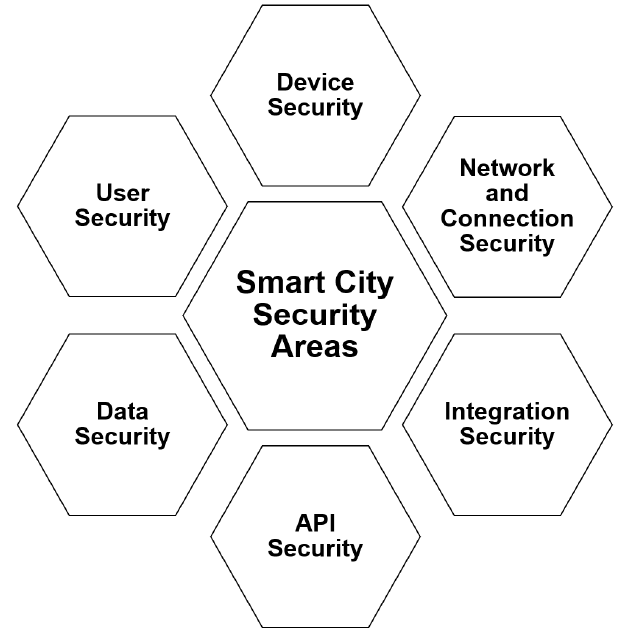
Figure 10. Smart city security